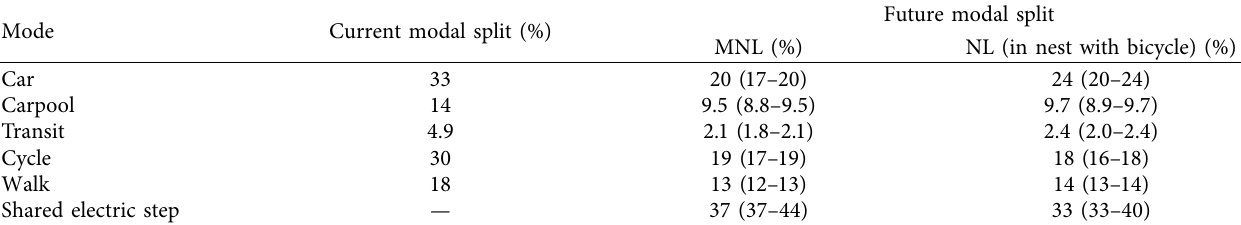
Table 10: Calculated modal split electric step with sensitivity analysis ranges between brackets based on a 20% variation of all mode attributes.